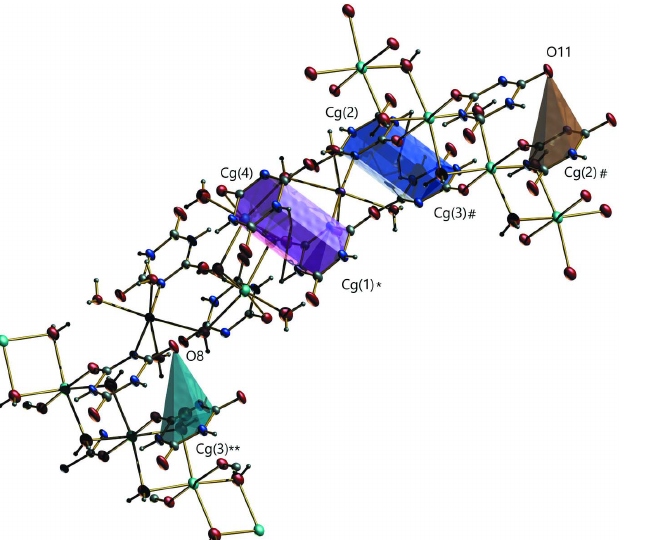
Figure 2 (cid:4) (cid:2)(cid:2)(cid:2) (cid:4) and C—O (cid:2)(cid:2)(cid:2) (cid:4) interactions present in the complex. Cg 1, Cg 2, Cg 3 and Cg 4 are the centroids of the N1–N3/C1–C3, N4–N6/C4–C6, N7–N9/ C7–C9 and N10–N12/C10–C12 rings, respectively. Symmetry codes: (*)